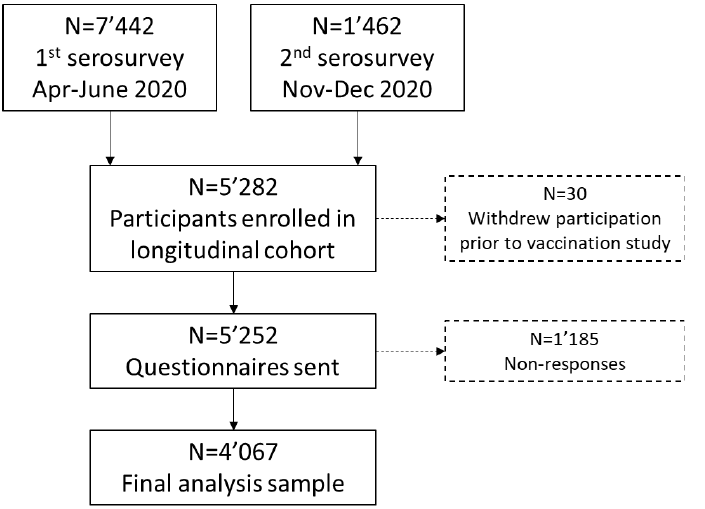
Figure S1. Flow chart of the Specchio-COVID19 Vaccination